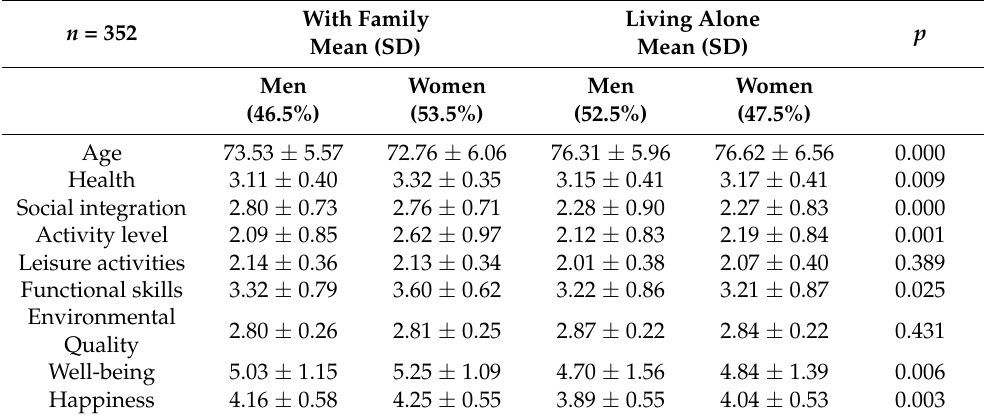
Table 2. Characteristics of the sample by sex and type of cohabitation, controlling for age in years. With n = 352